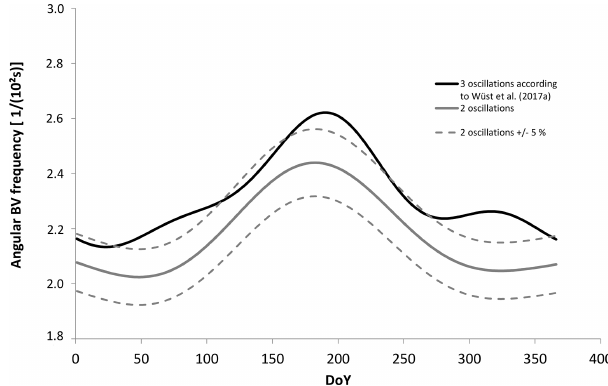
Figure 8. Comparison of the approximation of the BV frequency in the Alpine region as it was proposed by Wüst et al. (2017a) based on three oscillations (black) and in this paper (grey, values of the pixel at 45 ◦ N and 10 ◦ E are